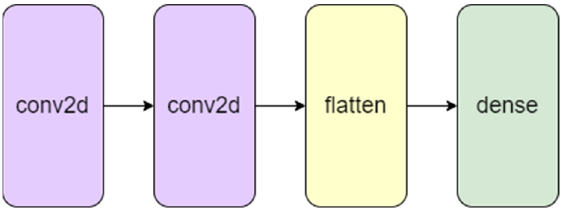
Figure 9. Visual representation of the proposed CNN model for RUL prediction.